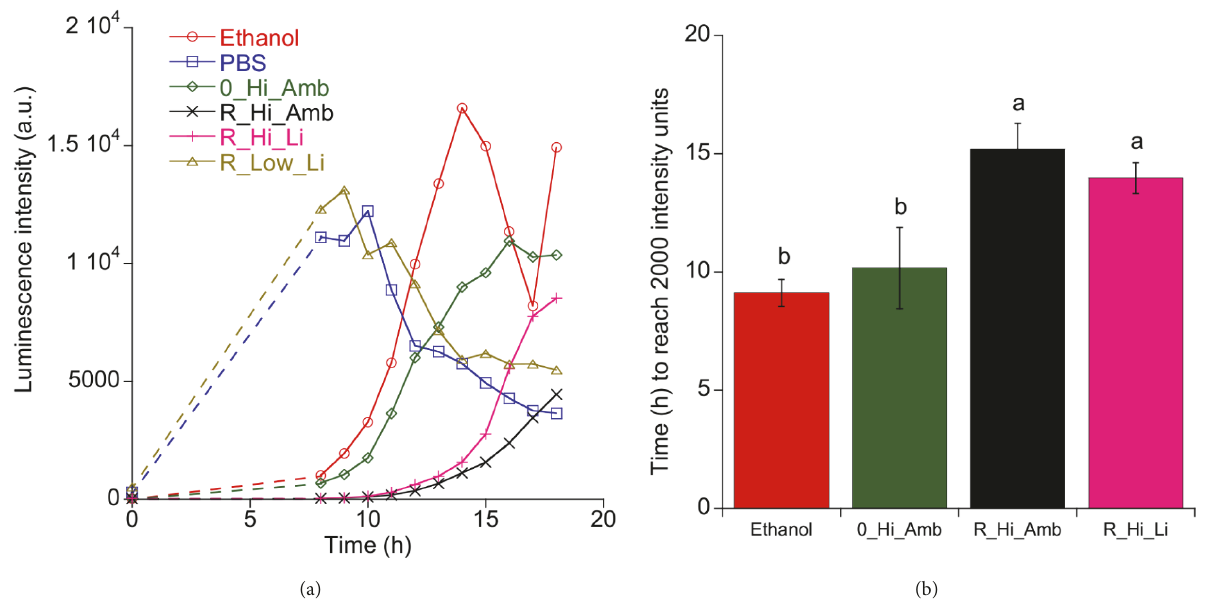
Figure 3: Regrowth of S. epidermidis after different debridement treatments. (a) Average luminescence intensity measured during reincubation after debridement with different treatments (n=8). (b) Average time after reincubation to reach a luminescence intensity unit of 2000 for four of the test groups. Different letters associated with the bars indicate statistically significant differences (Tukey post hoc test, p ≤ 0.05).